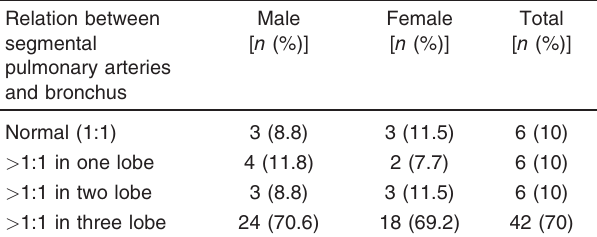
Table 4 Relation between segmental pulmonary arteries and adjacent bronchi in all cases